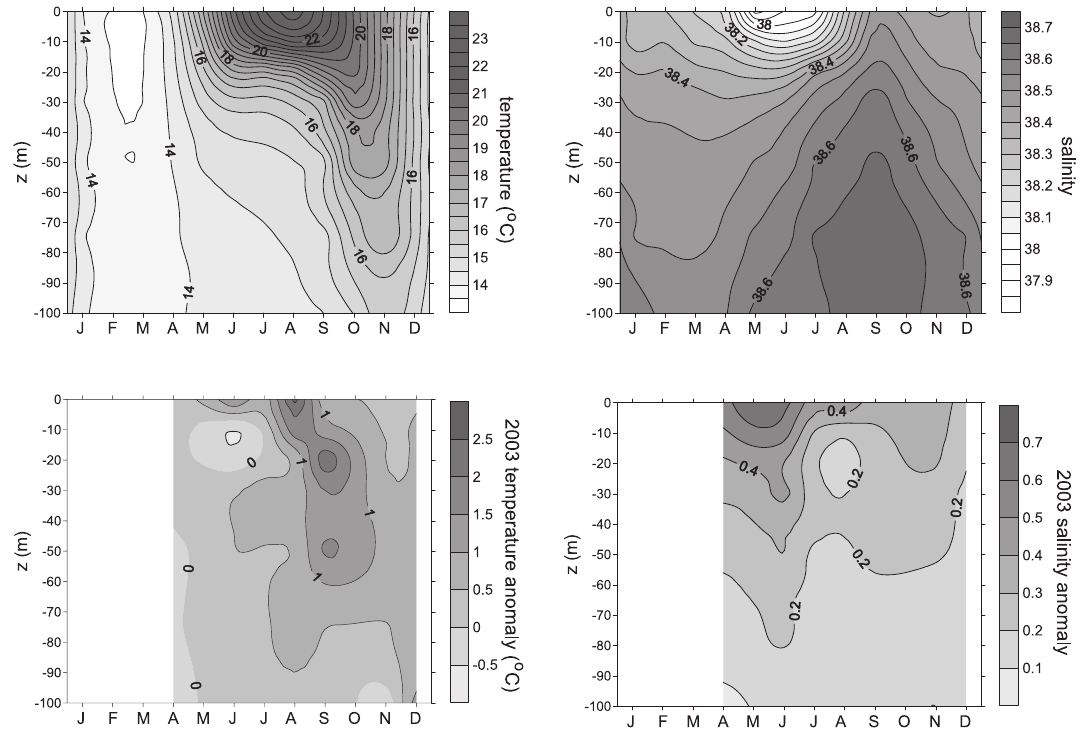
Fig. 7. Annual cycle of average temperature and salinity at the CJ009 station for the period 1962–1994 (upper panels), and the difference between 2003 values and the averages (bottom panels).